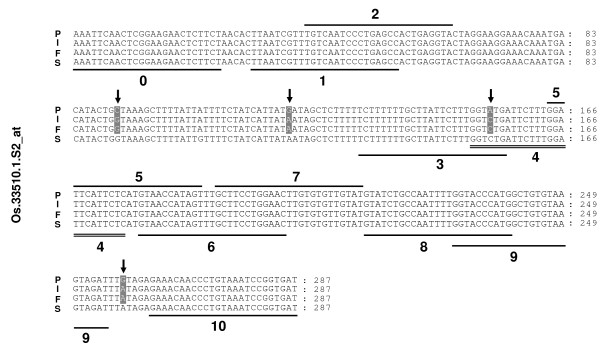
Nucleotide sequence alignment of amplicon sequences of a probe set. Polymorphic residues are highlighted in gray. Bars 0–10 indicate the positions of eleven probes in the probe set (Os.33510.1.S2_at). The position of SFP probe number 4 detected by the RPP method is double-underlined. Arrows indicate SNPs. P, Pokkali; I, IR29; F, FL478; S, target sequence from SIF.